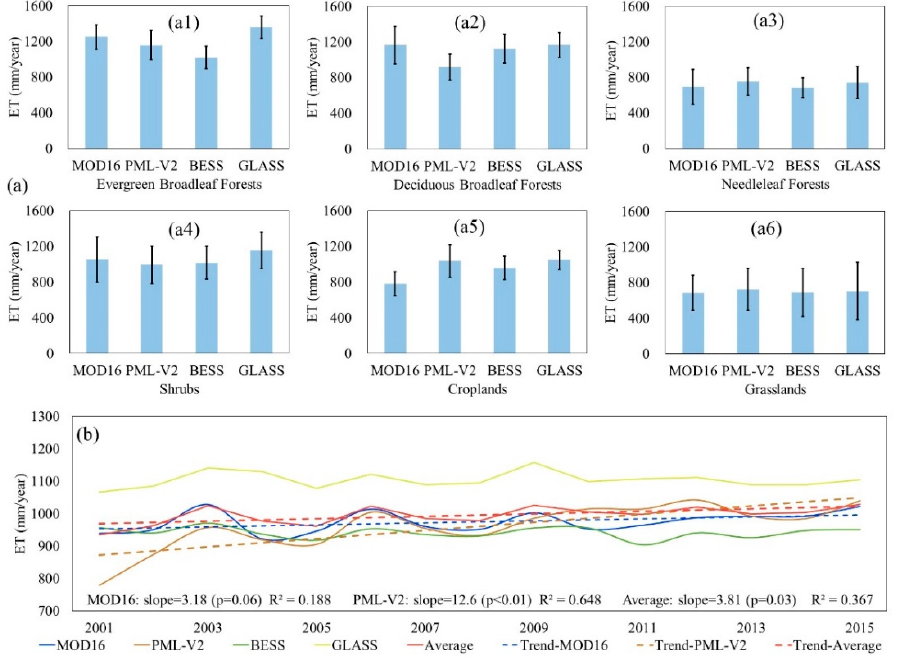
Figure 7. ( a ) Multi-year average ET of evergreen broadleaf forest ( a1 ), deciduous broadleaf forests ( a2 ), needleleaf forests ( a3 ), shrubs ( a4 ), croplands ( a5 ), and grasslands ( a6 ) over LMRB; ( b ) inter- annual variation of the four products and trend of MOD16, PML-V2, and the average ET during 2001–2015.